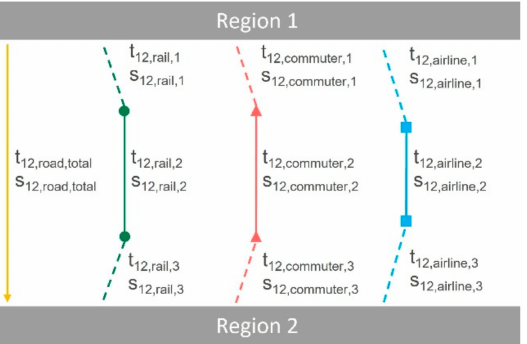
Figure 1. Journey segments and processes of modes of transportation, own